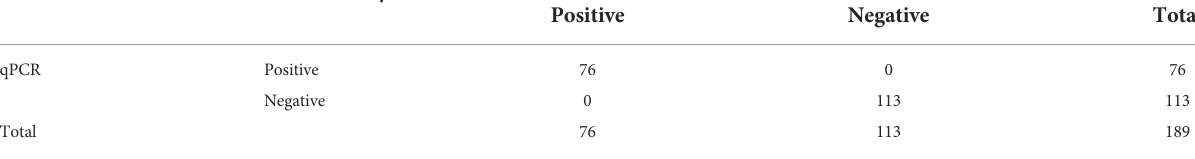
TABLE 3 Detection of the RPA-LFS system and qPCR for C. krusei